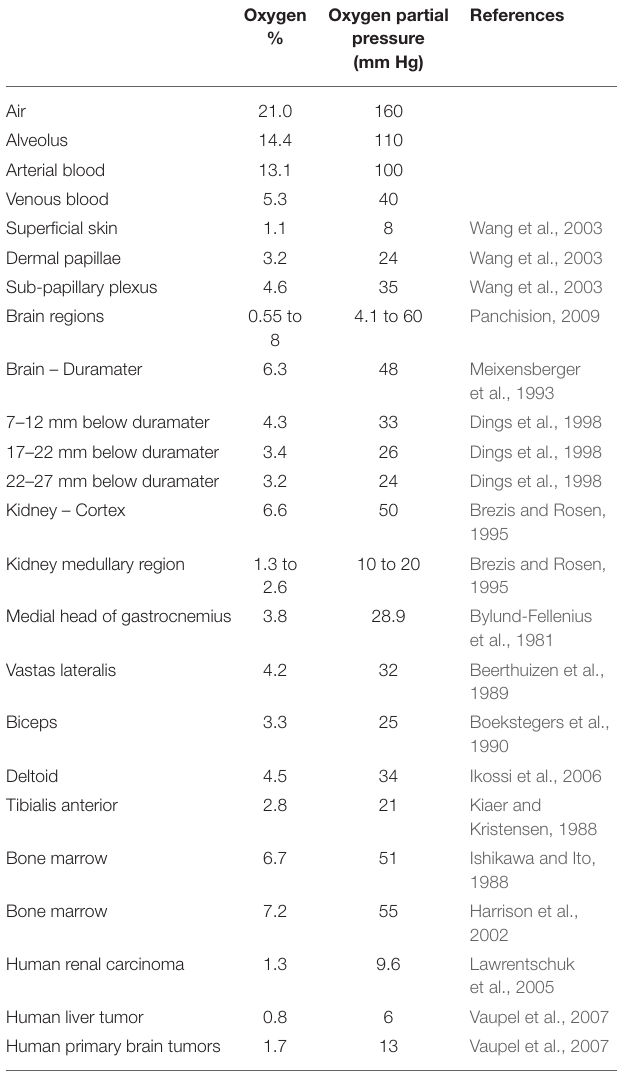
TABLE 5 | Oxygen concentration in various body